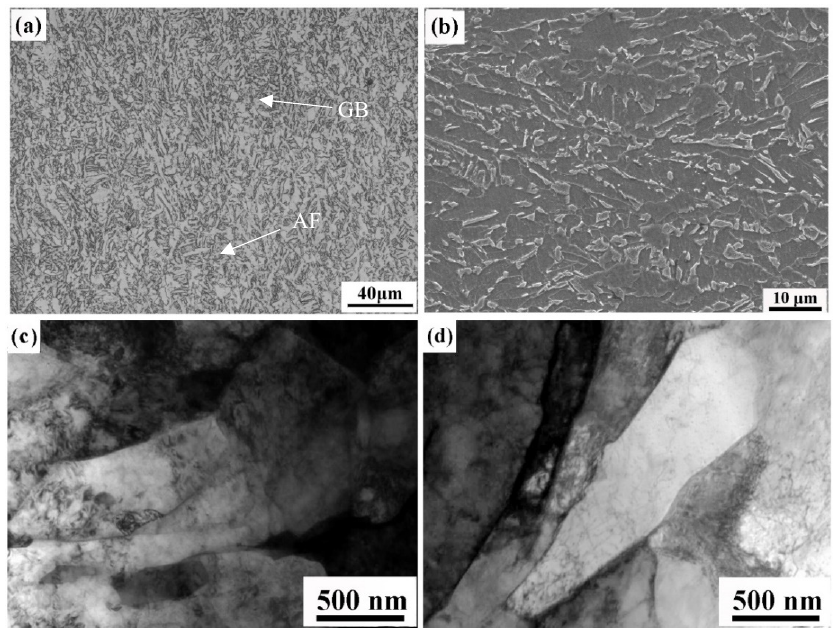
Figure 2. The microstructure of as received hot-rolled plate of pipeline steel. ( a ) OP; ( b ) SEM; ( c ) and ( d ) TEM.